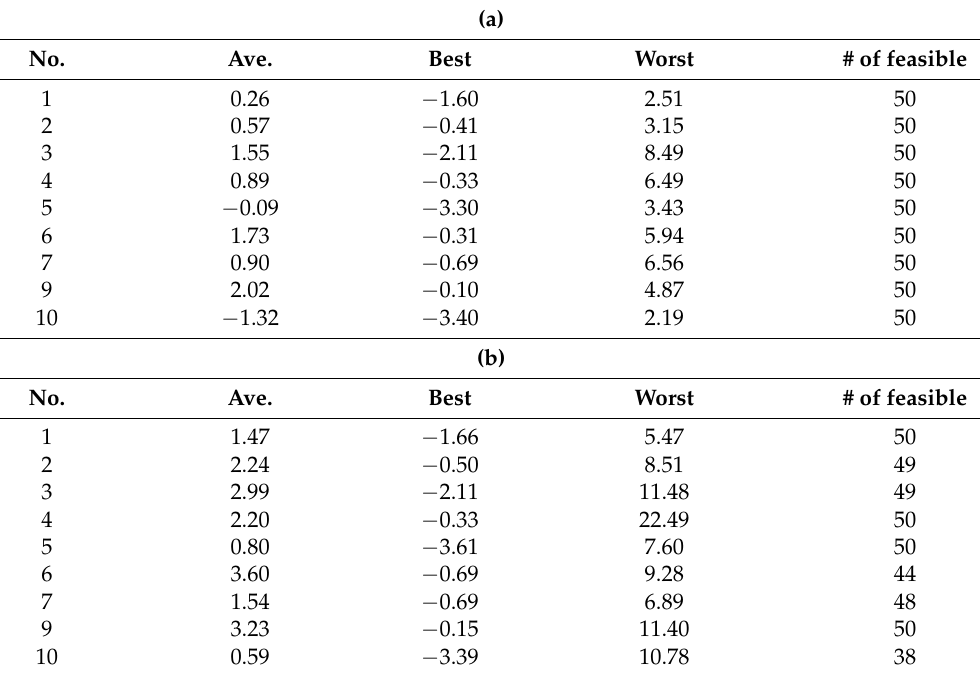
Table 8. Results of gaps in the method that adjust weight dynamically for n = 50. Negative values of average and best gaps mean that the methods can find better solutions than that found using the Gurobi optimizer 9.1.1 within 12 h. ( a ) Method 1 (Equations (20) and (21)). ( b ) Method 2 (Equations (22) and